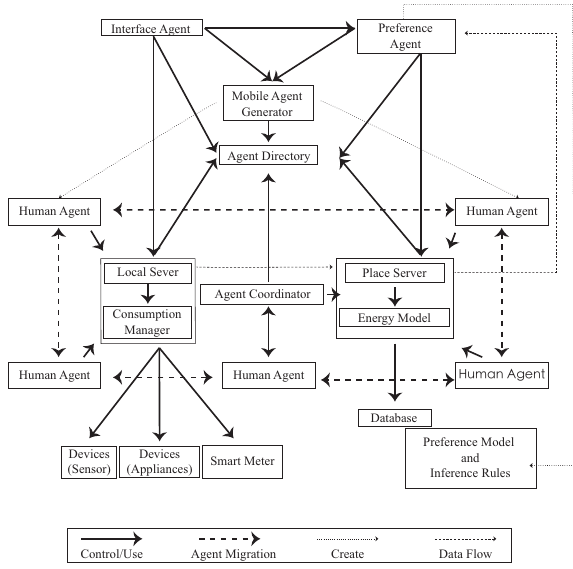
Figure 2. Smart sensor component data